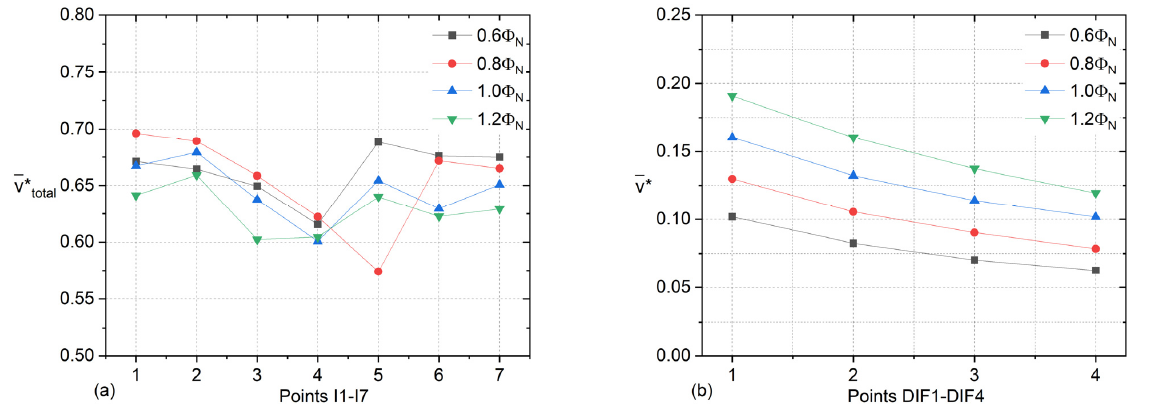
Figure 11. Averaged velocities of the points I1–I7 and DIF1–DIF4 at different flow rates, ( a ) averaged velocities at points I1–I7 and ( b ) averaged velocities at points DIF1–DIF4.